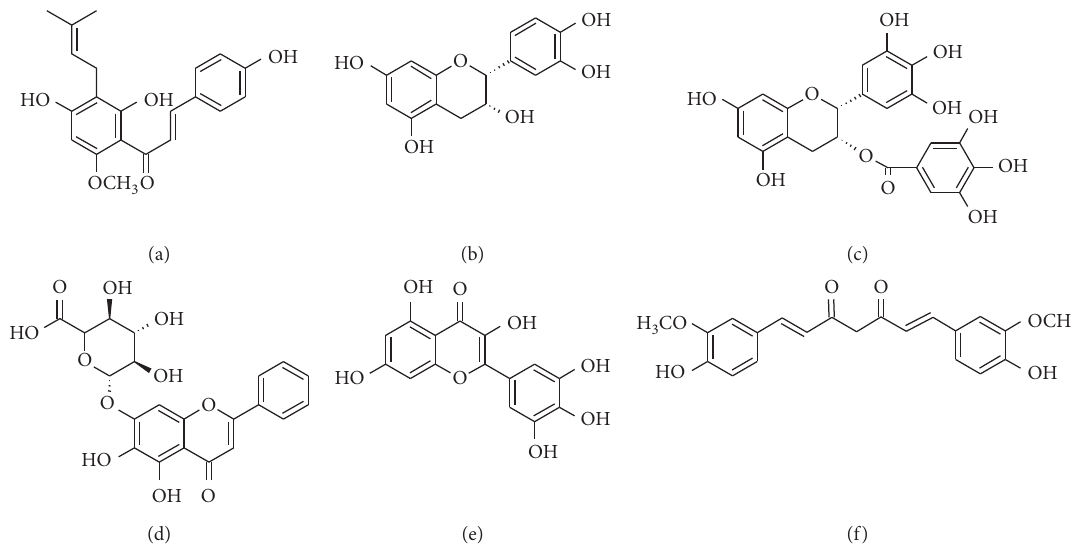
Figure 4: Chemical structure of representative simple and related phenolic compounds with antiviral activity against HIV-1. (a) Xan- thohumol. (b) ( − )-Epicatechin. (c) ( − )-Epigallocatechin. (d) Baicalin. (e) Myricetin. (f)